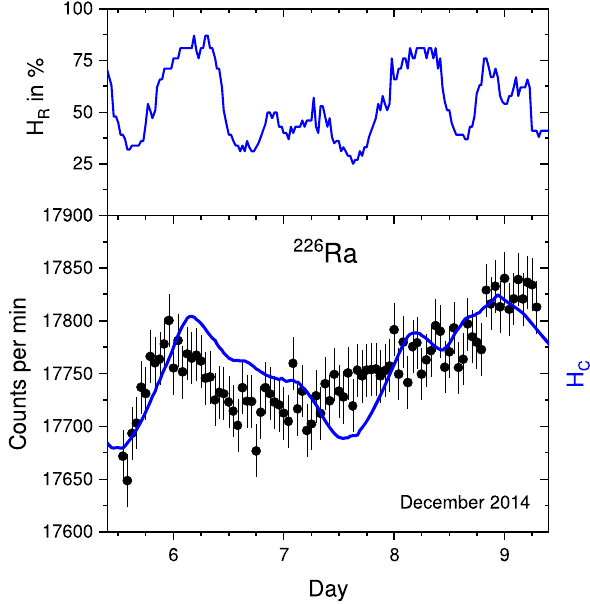
Fig. 2 Relative humidity in the Valencia region (top) in the period 5- 9 Dec 2014 [68]. Qualitative comparison (bottom) of measured 226 Ra decayrates[27–29]withtheaccumulated-humiditymodel H C ( t ; ¯ H R = 50% ,(cid:3) t = − 7h ) in Eq.